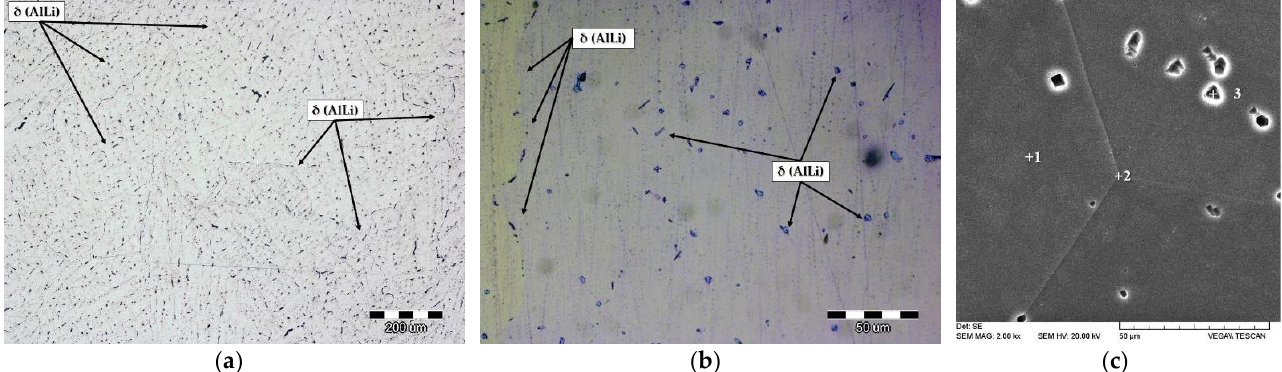
Figure 7. The microstructure of the sample in solution-hardened condition: ( a ) etched with Keller’s etching solution; ( b )